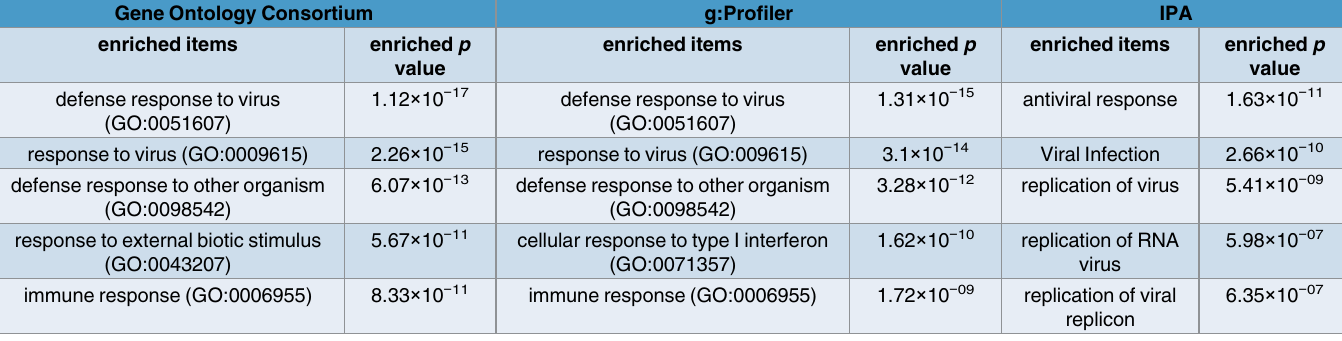
Table 2. The functional enrichment of the overlapped genes among sDNB for influenza virus infection. Gene Ontology